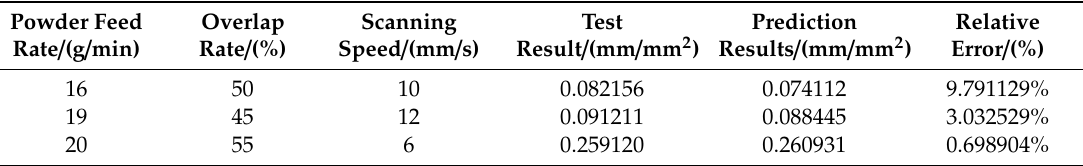
Table 7. Verification of the optimized neural network